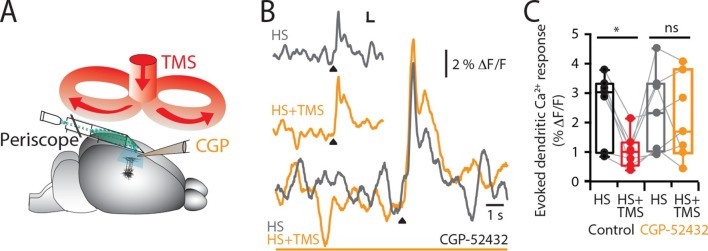
TMS causes GABAB-mediated inhibition of layer 5 dendrites.(A) Schematic of the experimental design illustrating the application of the GABAB antagonist CGP52432 on the cortical surface. (B) Typical dendritic Ca2+ response to hindpaw stimulation (HS) alone (grey) and during a single TMS pulse (orange, HS+TMS) during cortical CGP. (C) Block of TMS-evoked inhibition of the dendritic sensory response in the presence of CGP52432 compared with control (prior to CGP52432; HS, black; HS+TMS, red; n=7). p<0.05 (*).